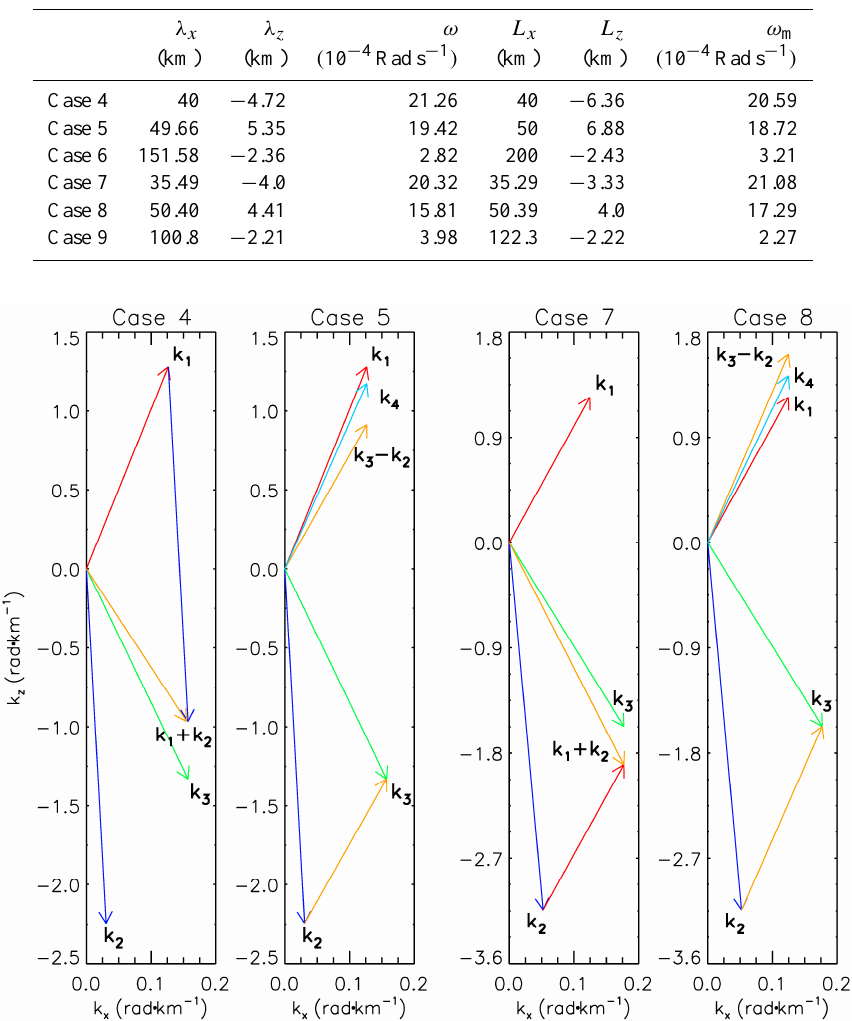
Fig. 9. Wave vectors of interacting waves and matching wave vectors in cases 4, 5, 7 and 8.